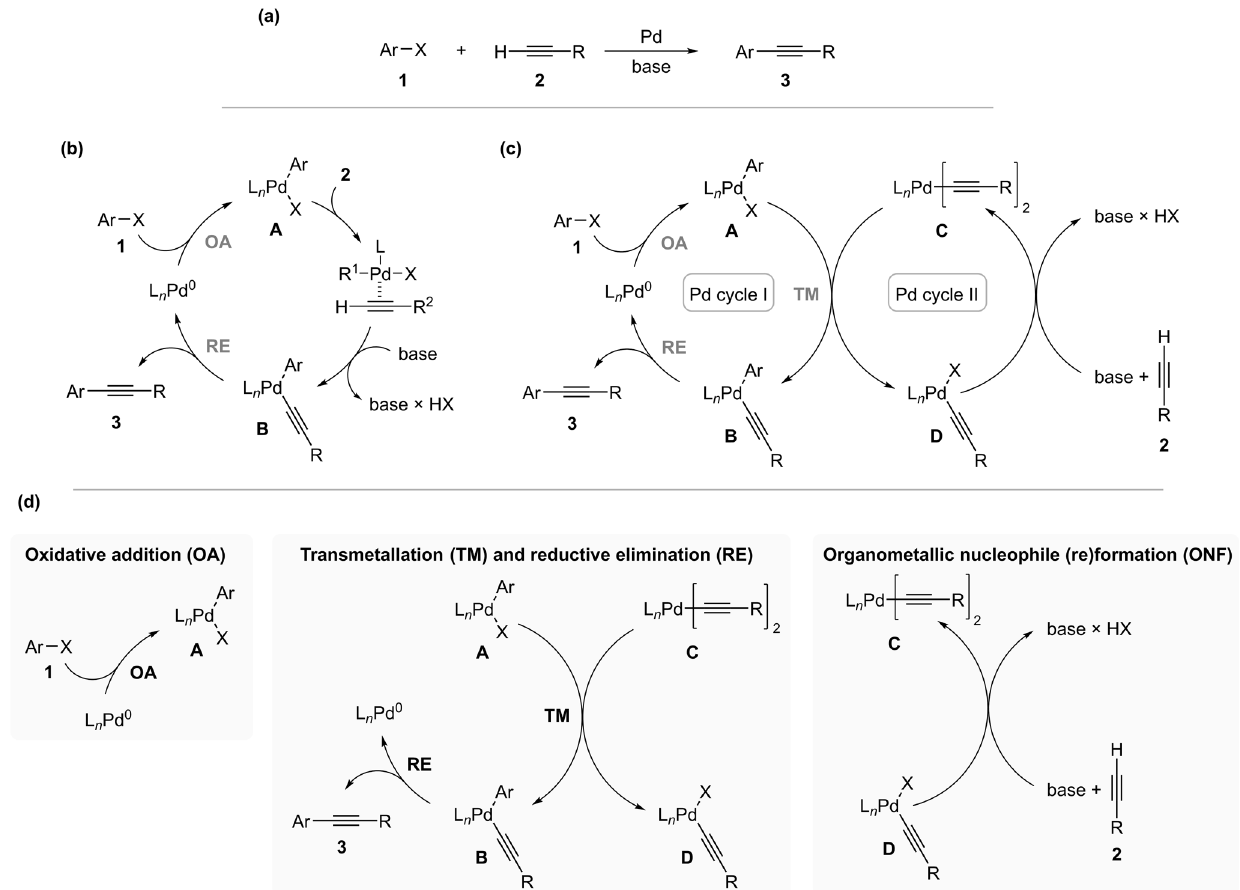
Fig. 1 Investigated reaction and its mechanistic analysis. a Palladium catalysed cross-coupling between aryl or vinyl halides and terminal alkynes. b Monometallic and c bimetallic mechanistic proposal. d Disassembly of the proposed bimetallic mechanism on elementary reactions. Cis – trans isomerization steps are omitted for clarity. OA oxidative addition, TM transmetallation, RE reductive elimination.